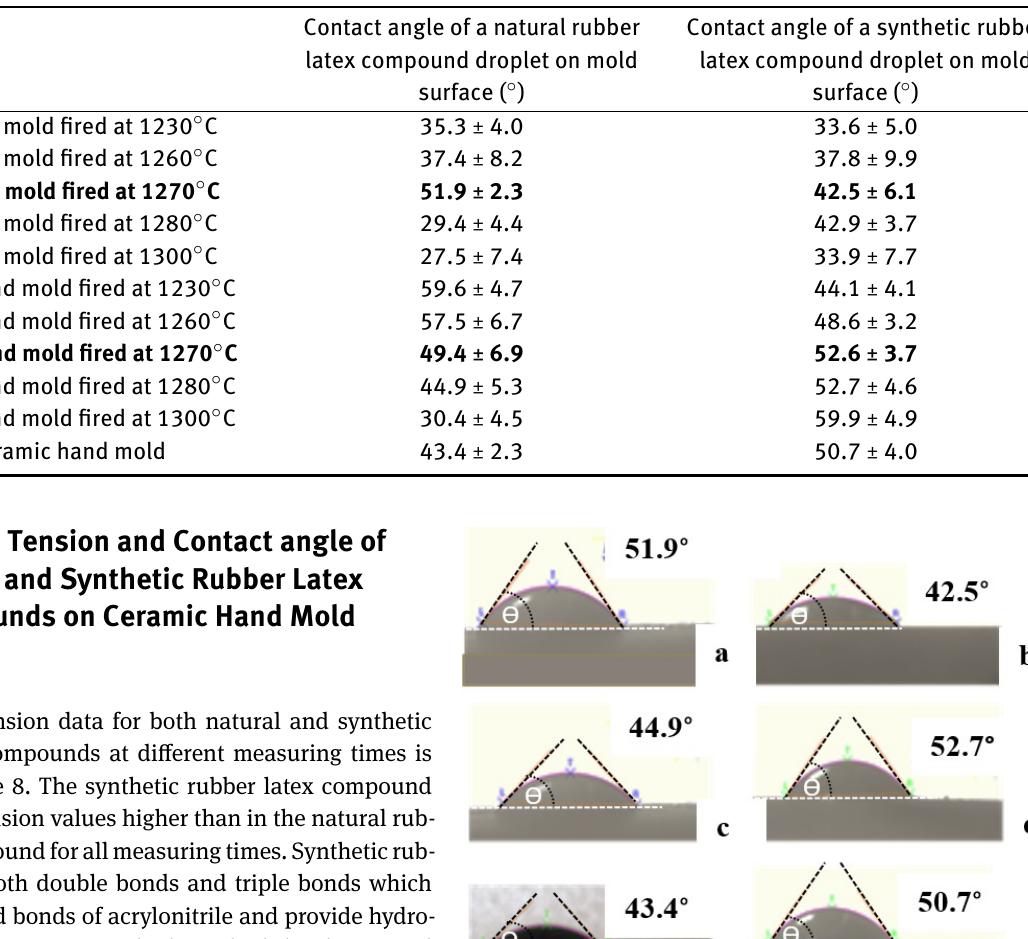
Table 9: Comparison of contact angle values between natural and synthetic rubber latex droplest on ceramic hand mold surfaces coated with calcium chloride (CaCl 2 ) made of eggshell